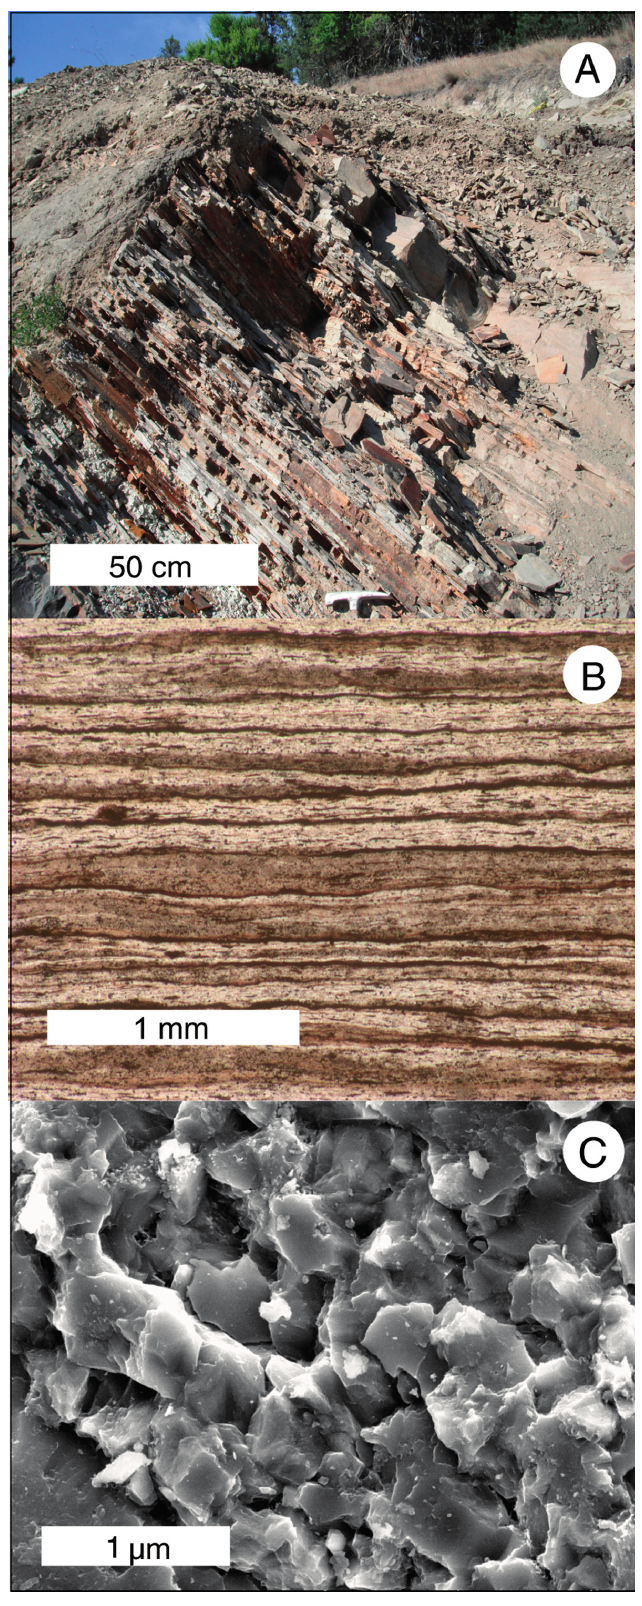
Figure 6. Lower siliceous shale unit: ( A ) outcrop view; ( B ) thin section view under polarized light; and ( C ) SEM photomicrograph (specimen WWU SR-1). Diagenetic recrystallization has produced a granular texture that obliterates the original diatom